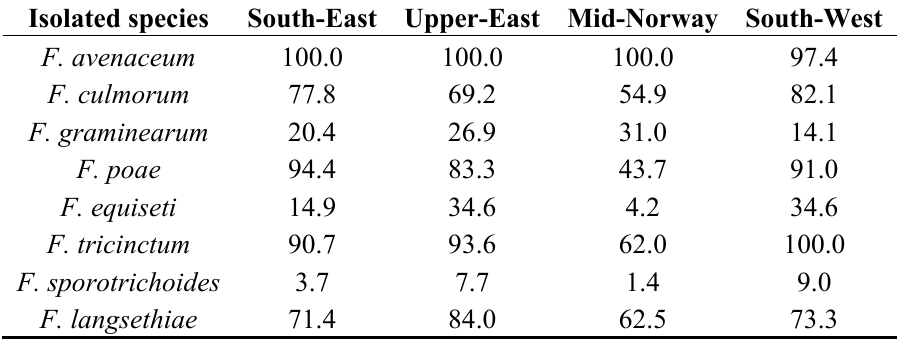
Table 4. Occurrence (%) of Fusarium spp. isolated from barley samples from four regions in Norway from 1994 to 1996, as determined by Kosiak et al. [5].